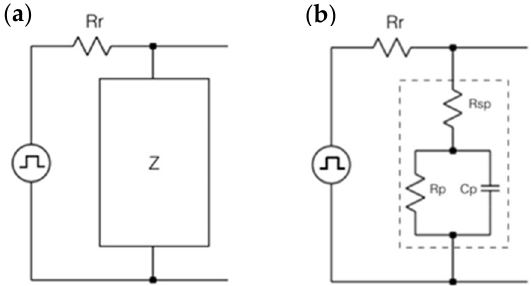
Figure 6. Sensor node structure with current-to-voltage converter ( a ) connected in series to the impedance transducer ( b ) where the relation between the capacitance and the properties of the liquid under test.